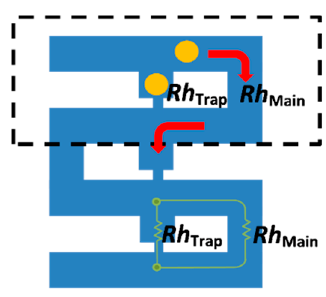
Figure 10. Simple schematic of single-cell trapping channel with the hydrodynamic resistance.